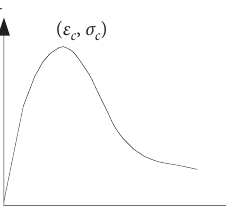
Figure 2: Optimized postpeak mechanical properties of concrete under uniaxial